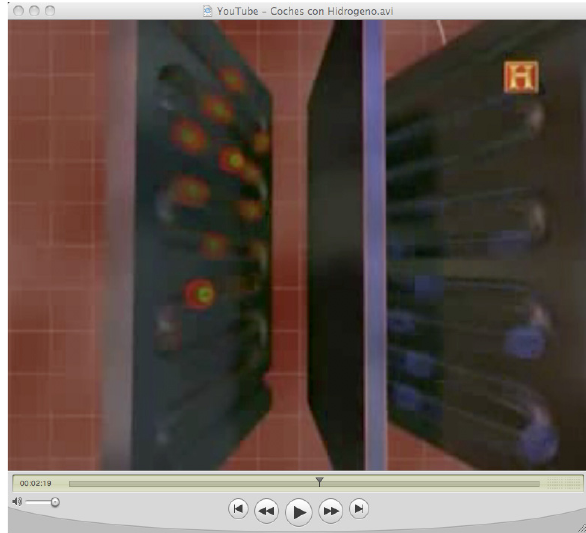
Figure 3. Snapshot of the video used.